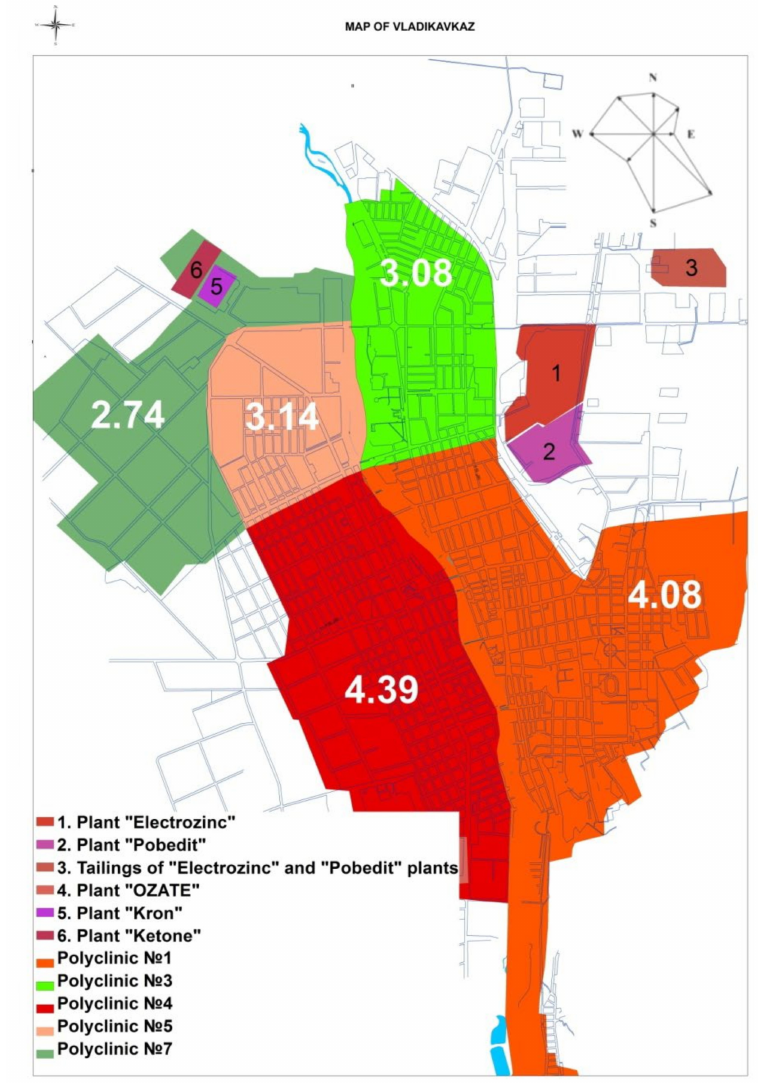
Figure 9. The incidence of malignant growths within the territory of urban polyclinics.